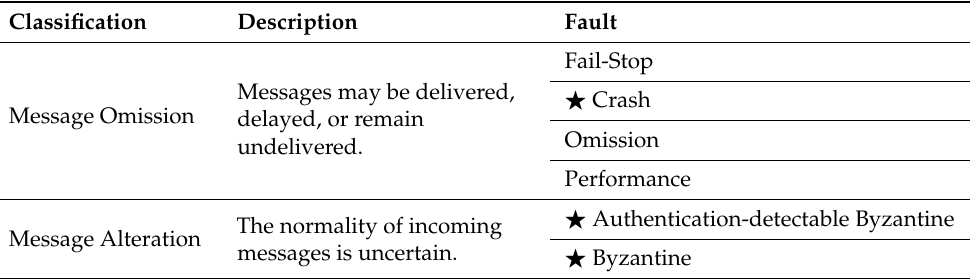
Table 1. Comparison of Byzantine fault tolerance before and after.